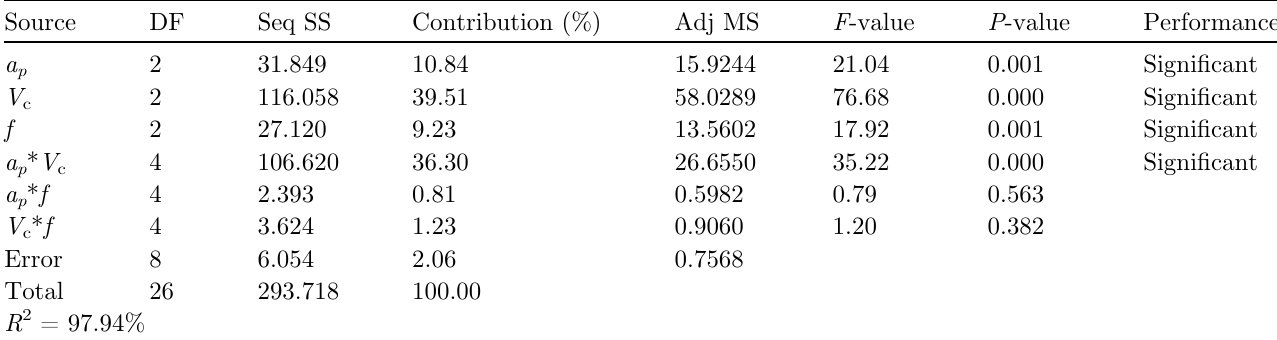
Table 8. Analysis of variance results for power consumption